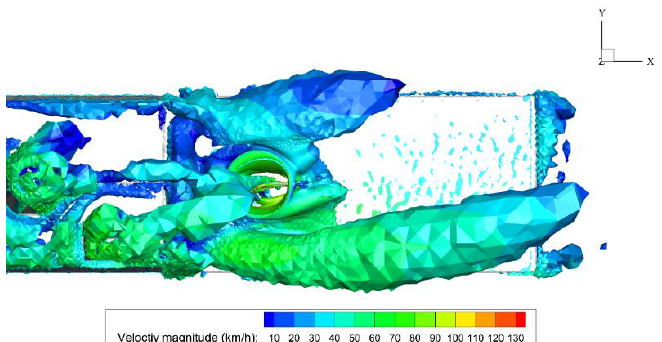
Figure 13. Vortex nephogram under 30° and 55 km/h WOD condition.